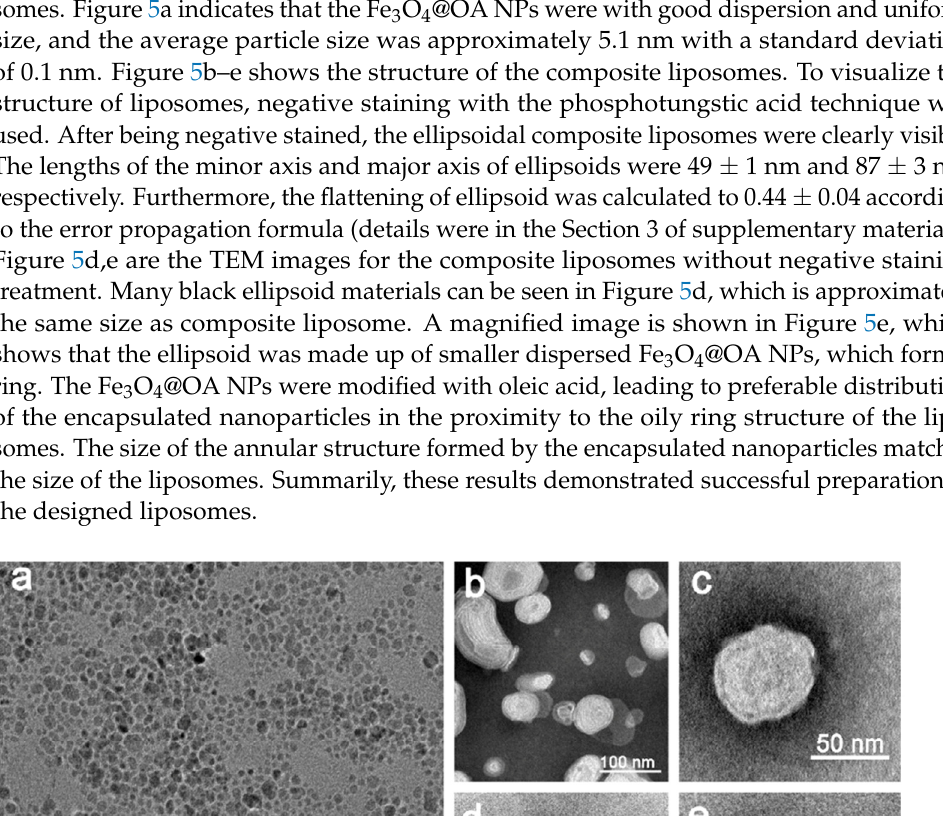
Table 2. Elements content of composite liposomes.